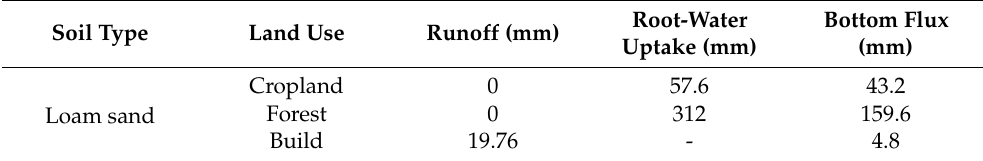
Table 4. Cumulative recharge fluxes of different simulation units from May 2005 to April